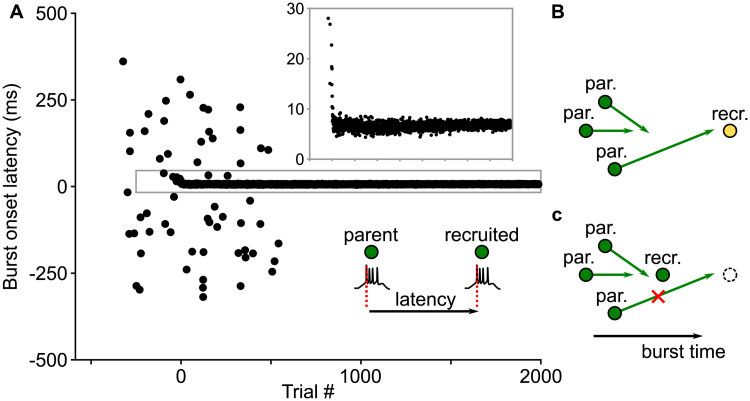
Decrease in the burst onset latency of the recruited neurons leads to pruning of long delay connections.A: Burst onset latency between the parent and the recruited neurons decreases during recruitment. Early in the recruitment, the recruited neurons are immature can still spontaneously fire, hence the burst onset latencies are scattered in a large range. This scatter disappears in later trials as the neurons become mature. The boxed area is scaled to show more clearly the burst events of the recruited neurons driven by the parents in all trials. Steady decrease of the burst onset latencies with the training trials is evident. B-C: Mechanism for pruning long delay connections. B: A neuron being recruited initially spikes at a large latency, which allows long delay connections to emerge. C: After the recruitment, the neuron spikes at a shorter latency, which makes the long delay connections to arrive late and be pruned via LTD.